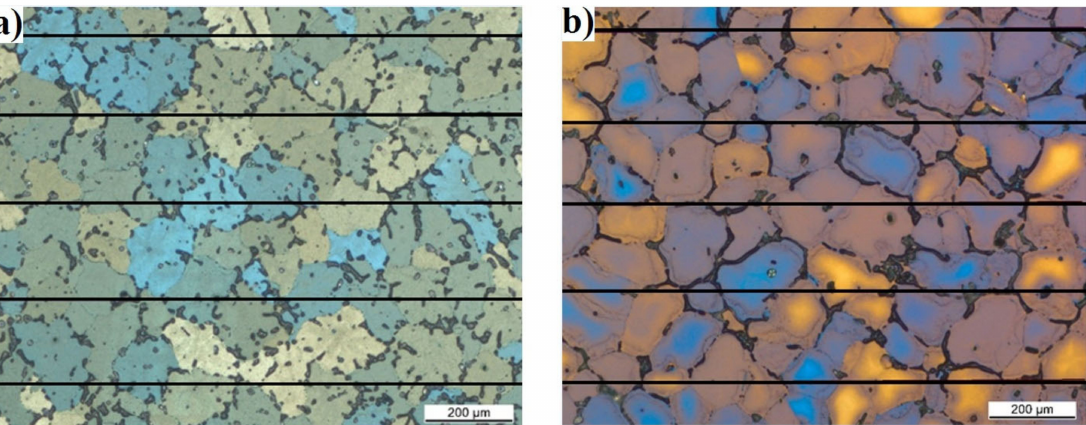
Figure 2. Microstructure of AA6026 with 1.1 wt.% Bi ( a ) industrially cast, ( b ) laboratory cast (electrolytically etched with Barker’s